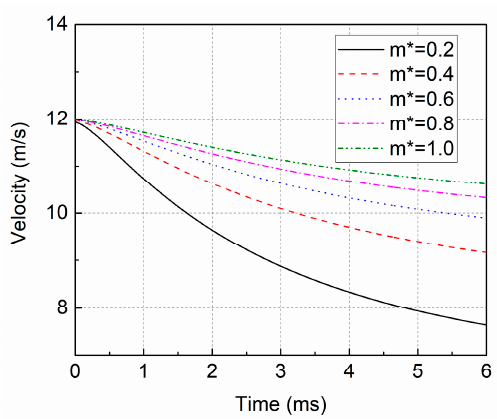
Figure 16. The velocity of the sphere with different masses during the free-fall water entry.